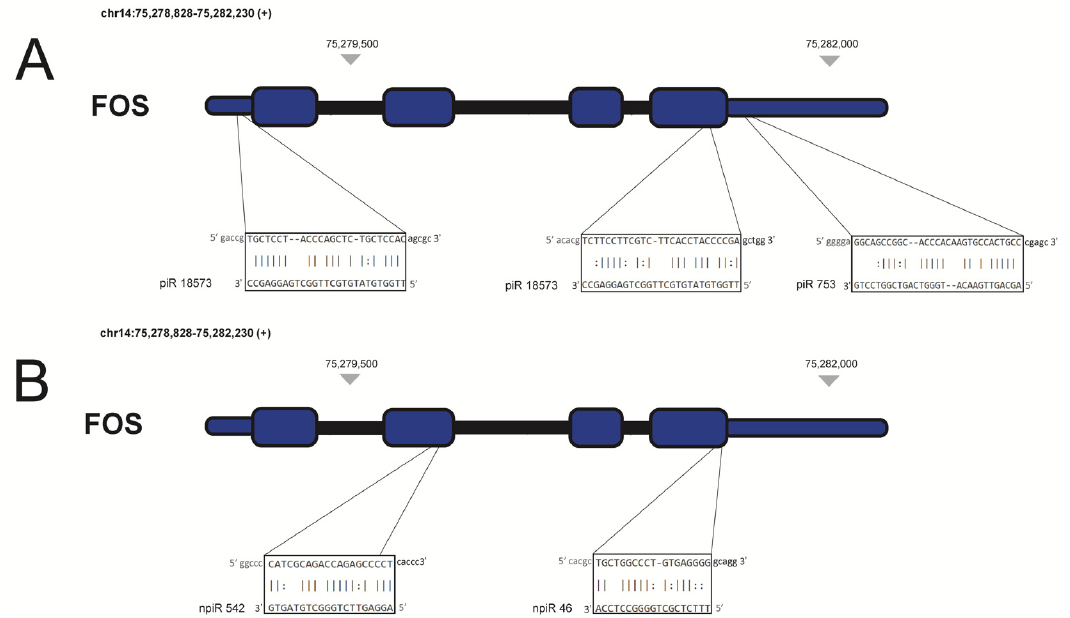
Figure 2. Known and novel piRNA targeting FOS mRNA transcript. piRNAs were shown to be differentially expressed during 1 and 2 h after Trypanosoma cruzi challenge of primary human cardiac myocytes. piRNAs are mapped to specific genic regions based on complementarity of piRNA/mRNA sequences using miRANDA and RNA22 software packages. Exons are represented by blocks, while grey lines represent intronic regions. Thinner blocks represent 5 ′ and 3 ′ untrans- lated regions (UTRs) at the terminus of FOS gene. ( A ) Known piRNAs upregulated at 1-h post infection ( B ) novel piRNAs upregulated at both 1 and 2 h post infection.